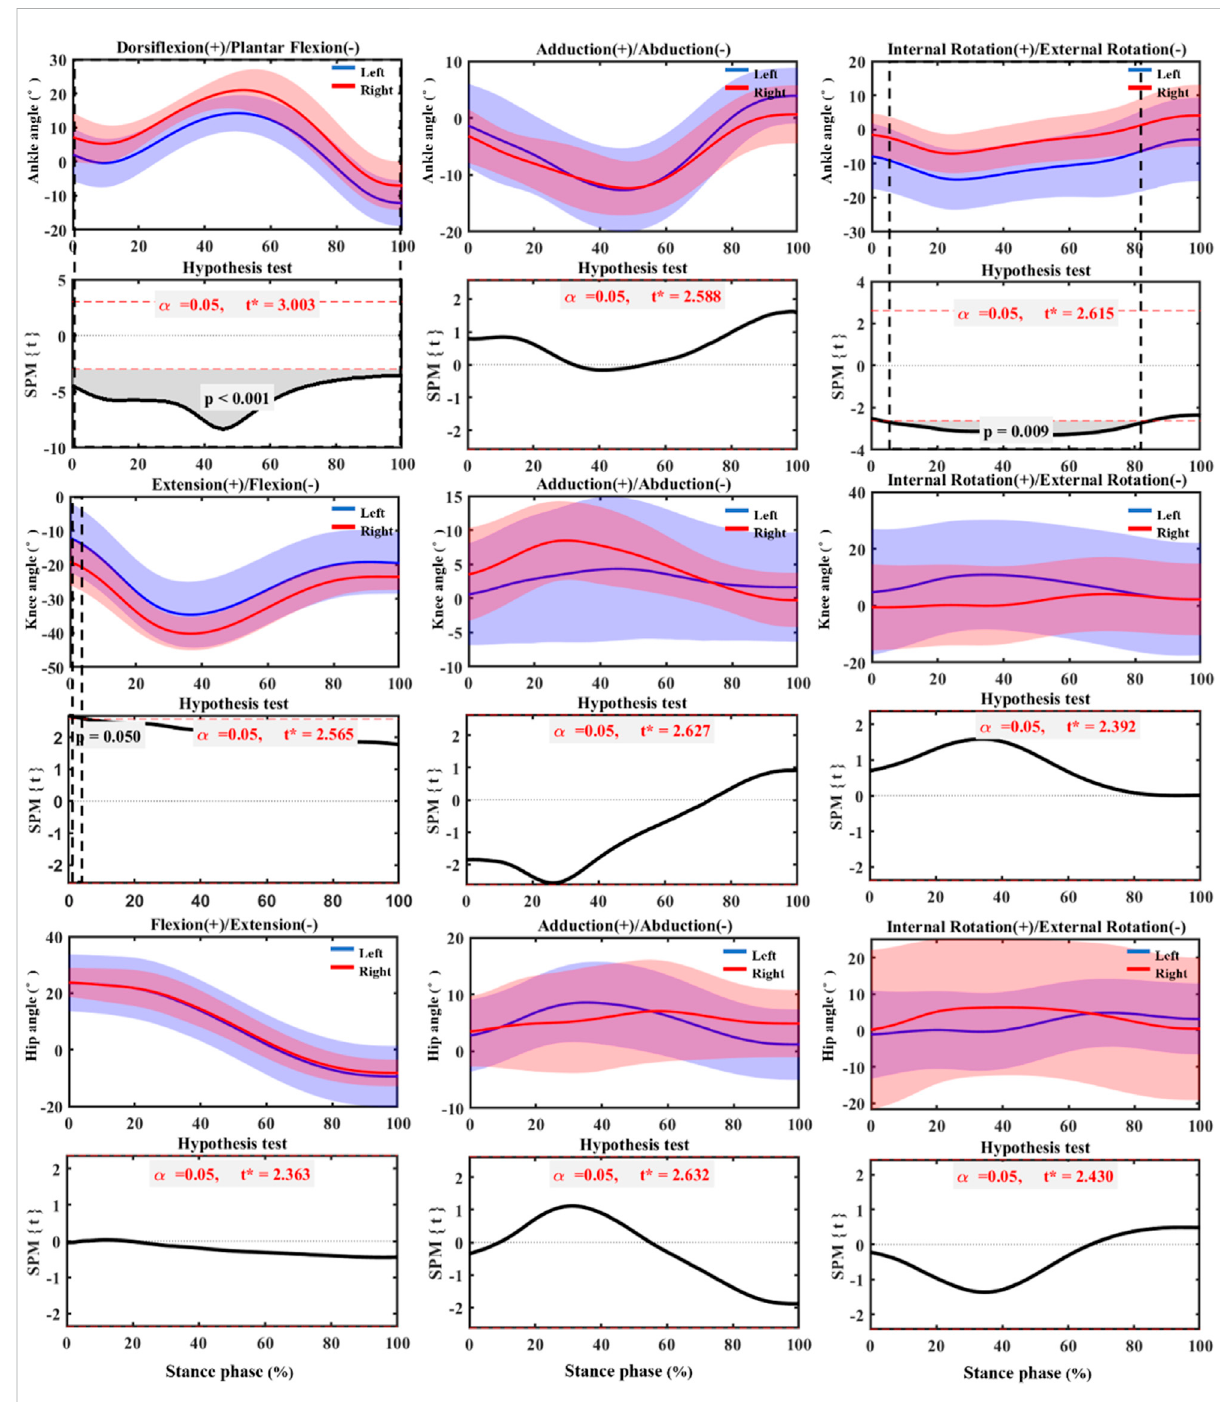
FIGURE 4 SPM_1d test of joint angle changes of bilateral lower limbs post fatigue during stance phase. Left: Left lower limb (non-dominant). Right: Right (dominant) lower limb.